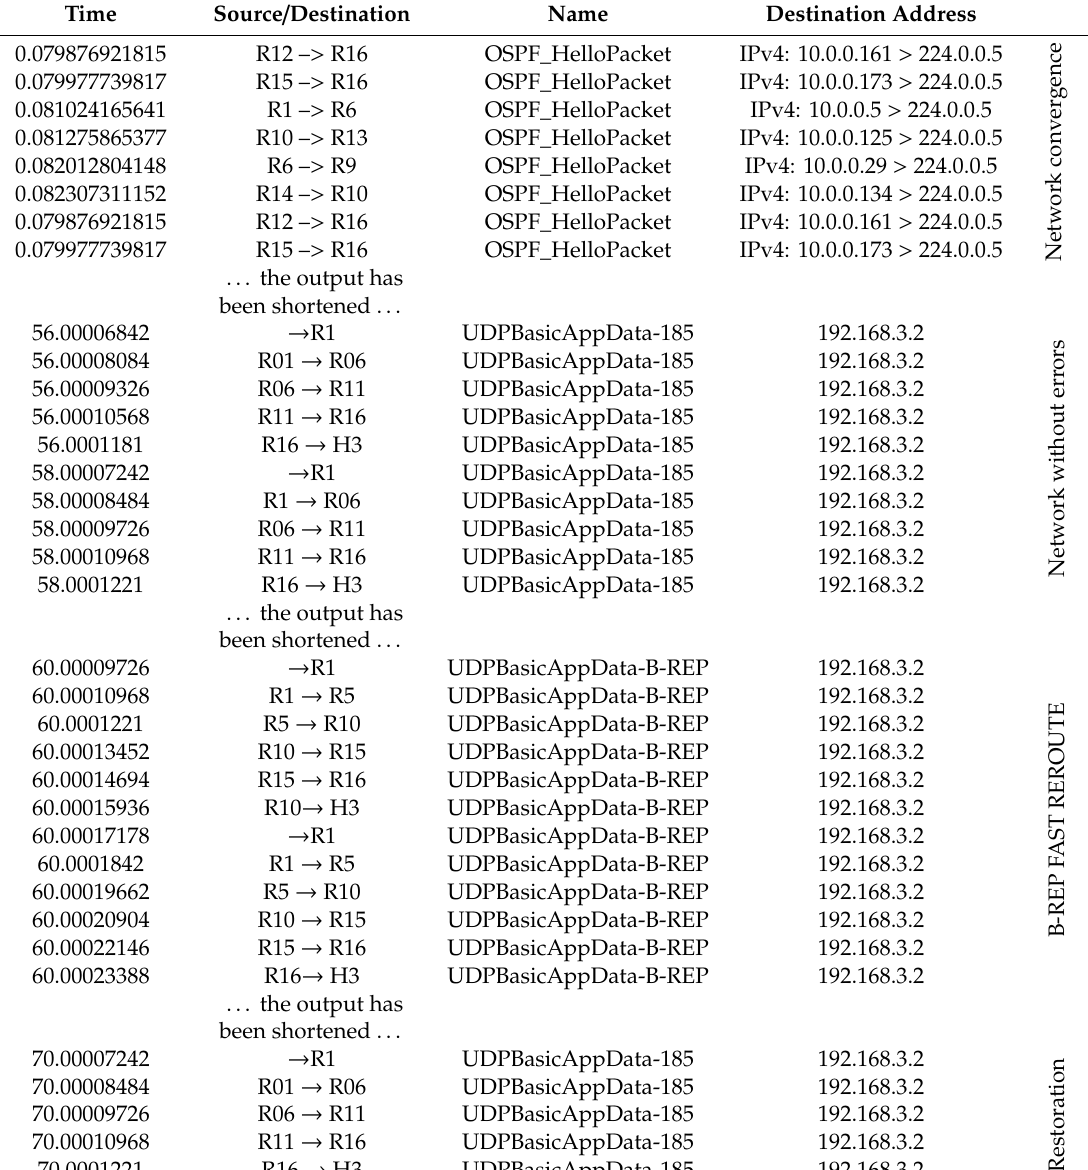
Table 6. Output from the OMNeT ++